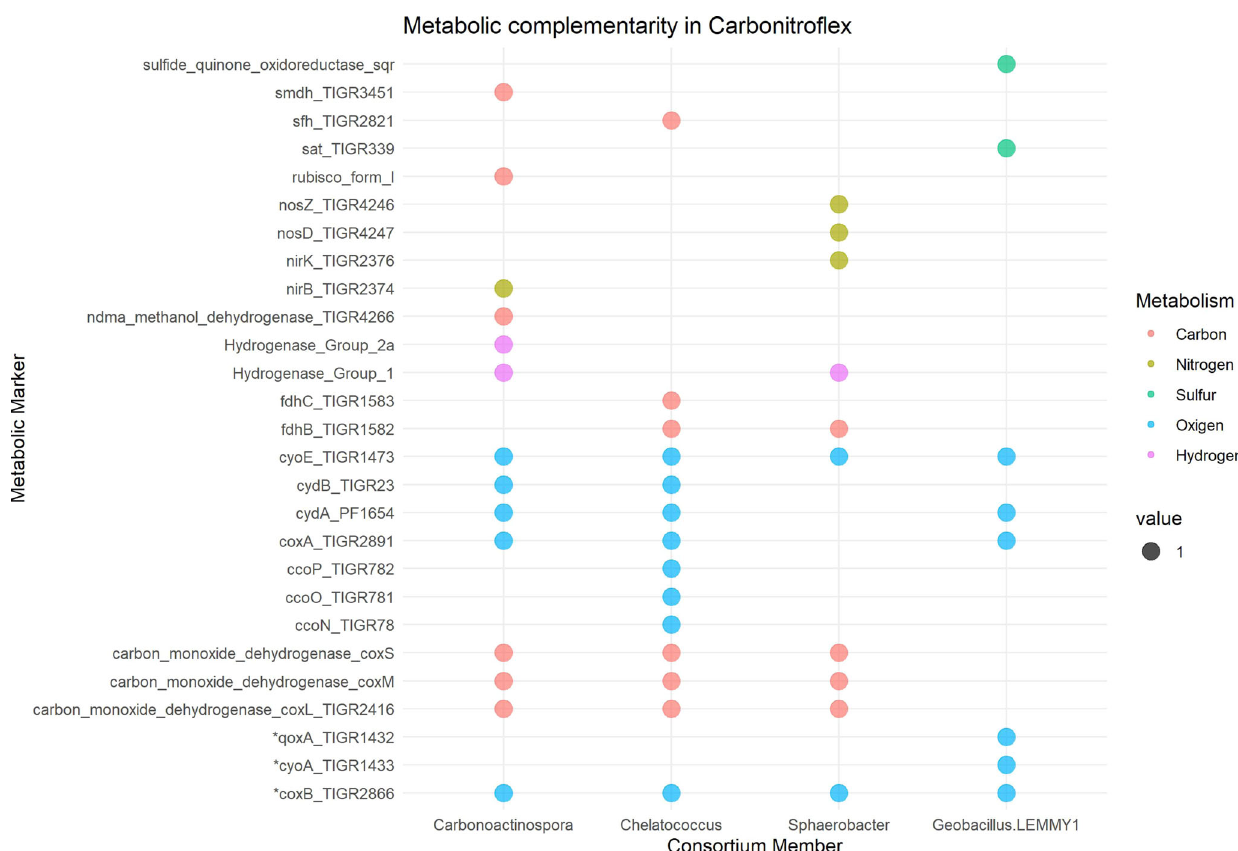
Fig. 5 Overall metabolic functions across the MAGs and Geobacillus spp. genome comprising the carbonitro fl ex consortium. Metabolic markers of carbon, nitrogen, sulfur, oxygen, and hydrogen cycles were identi fi ed via HMM search using the metabolisHMM tool. Metabolic markers with * represent genes with high homology. (See also Supplementary Data 2). Table 2 Growth of the Carbonitro fl ex consortium (CNF) or control strains in the presence of 15 N 2 gas.